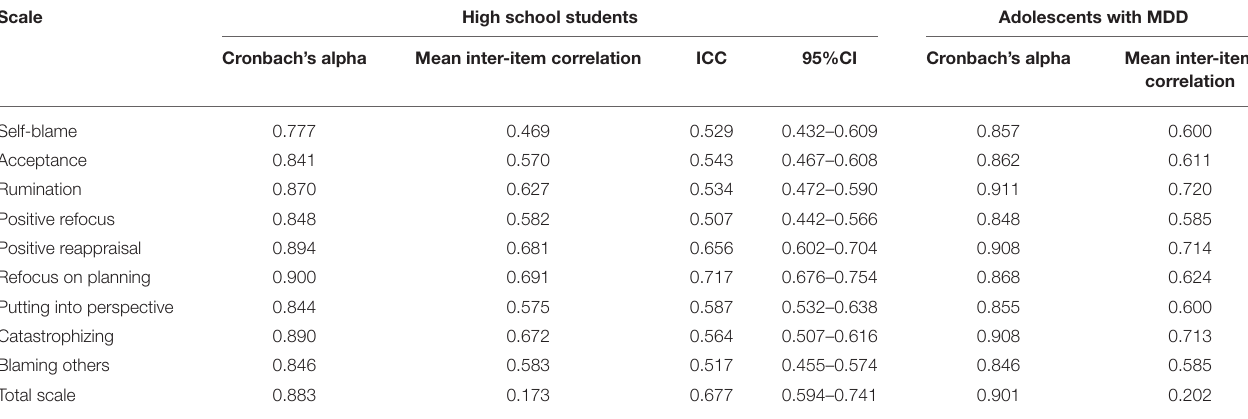
TABLE 2 | Reliability of the CERQ-C total scale and subscales. Scale